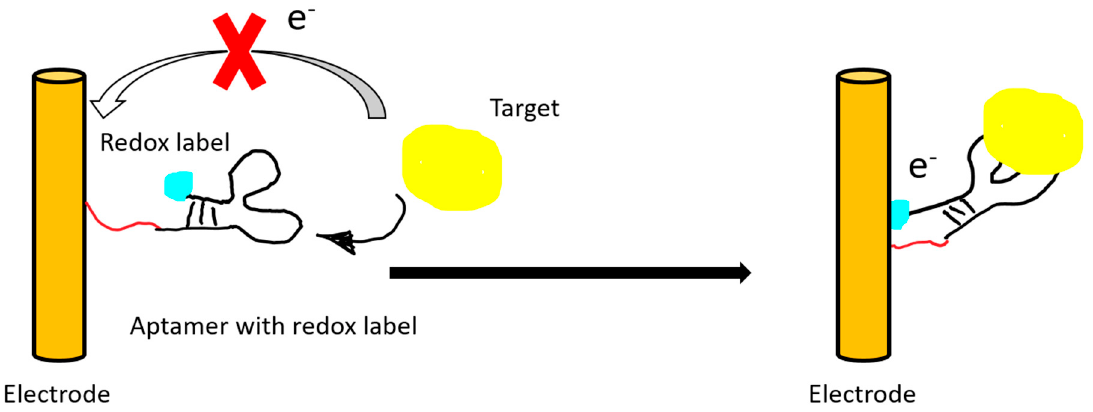
Figure 4. An illustration of a “signal on” electrochemical sensor. The electrical signal of the redox label is recorded after target binding and subsequent conformational change of the aptamer.